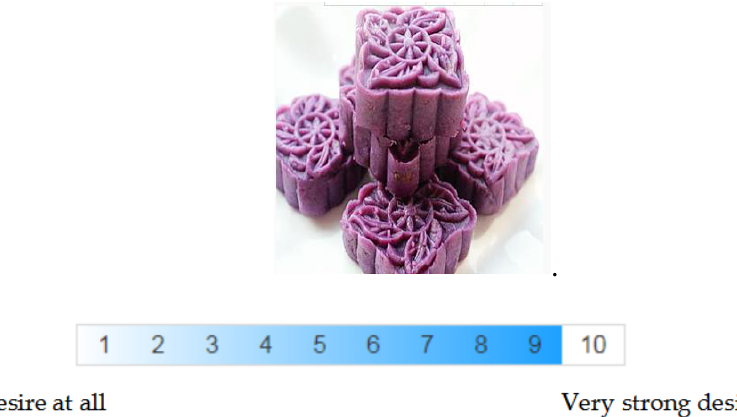
Figure A3. The picture of purple potato products (Solid food).